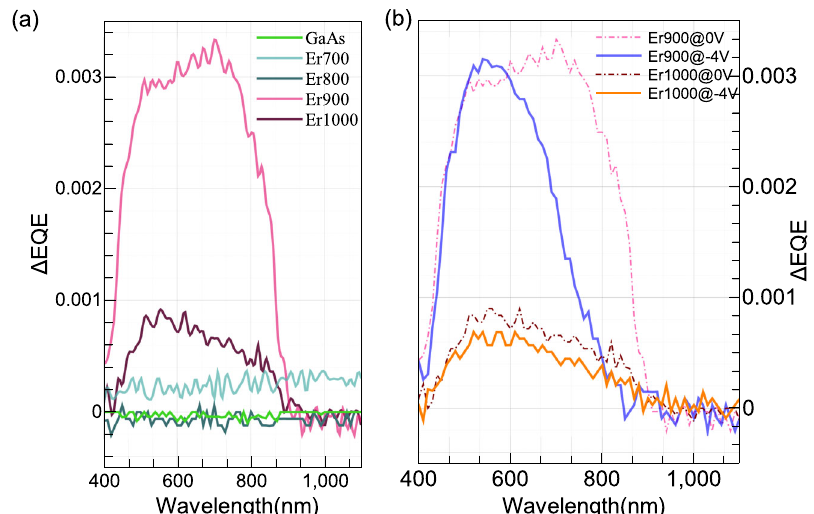
Fig. 4 Sequential two-photon absorption (STPA) measurement results. a Differential external quantum ef fi ciency ( Δ EQE) spectra measured at room temperature at a bias of 0 V (short circuit), and b the bias-voltage dependence of Δ EQE spectra for the samples Er900 and Er1000,